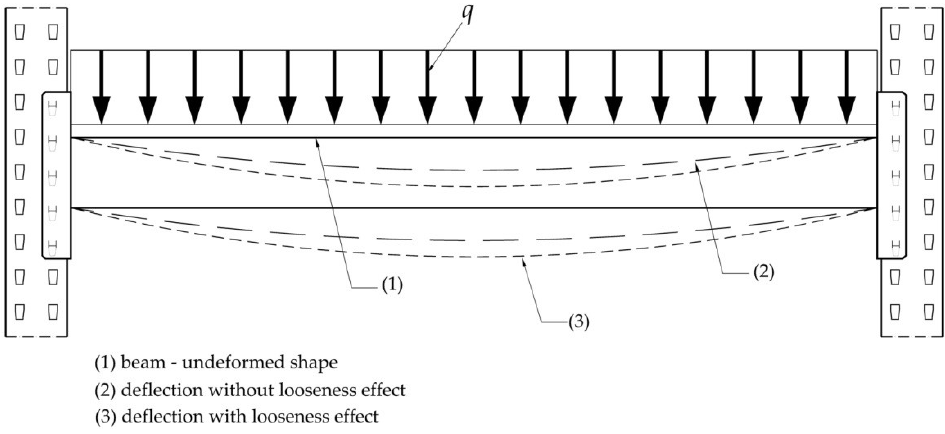
Figure 7. Looseness effect on the deflection of typical beam of the storage racking systems.